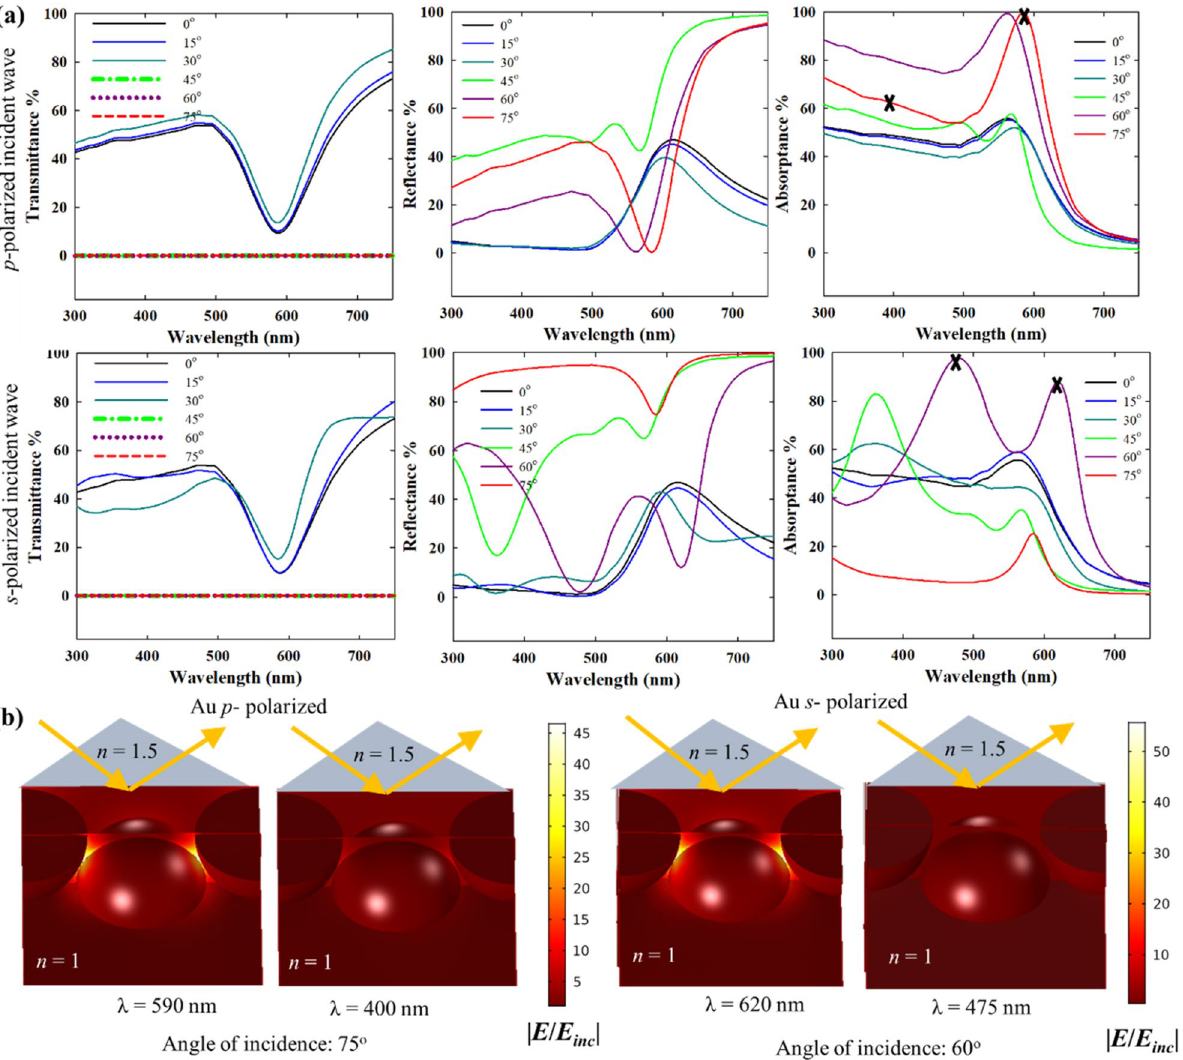
Figure 12. ( a ) Transmittance, reflectance and absorptance spectra of a close packed 20 nm Au nanoparticle film in the Kretschmann i.e. ATR configuration for p - and s -polarized incident wave, and varying incident angle ( n = 1.5 for the denser medium, n = 1 for the lighter medium and interparticle gap: 1 nm). ( b ) Near-field enhancement with respect to the background evanescent field (in absence of the nanoparticles) for p and s -polarized (or TM and TE polarized)